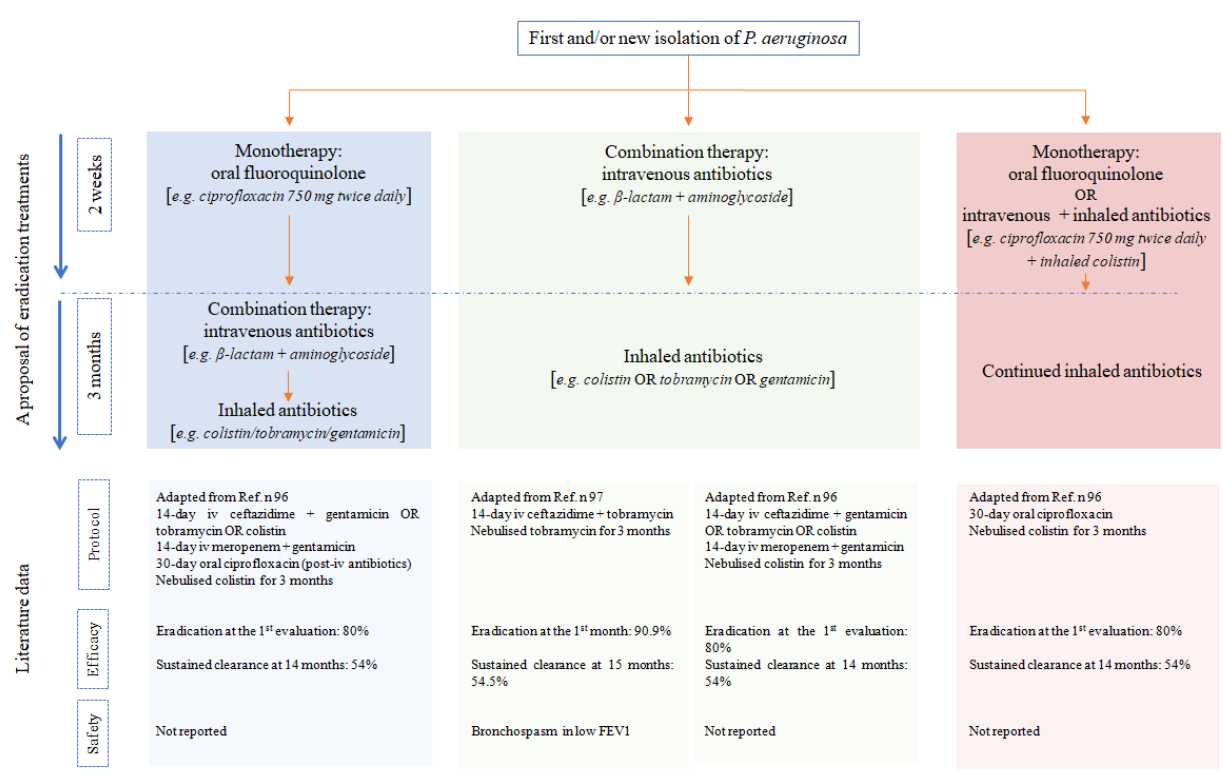
Figure 1. A proposal for eradication treatment pathways for isolation of P. aeruginosa.